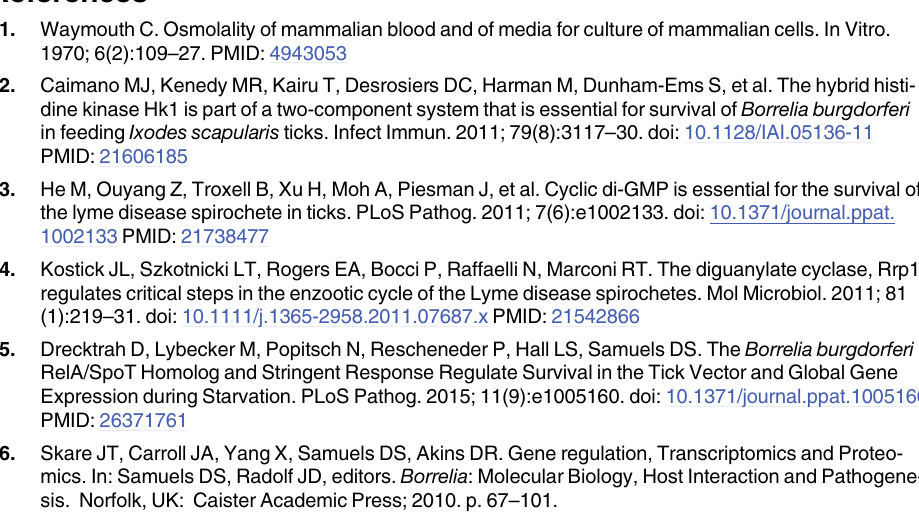
S1 Table. Mice infectivity of the proU and gltP mutants. S2 Table. Strains and plasmids of B . burgdorferi and E . coli . S3 Table. Q-PCR